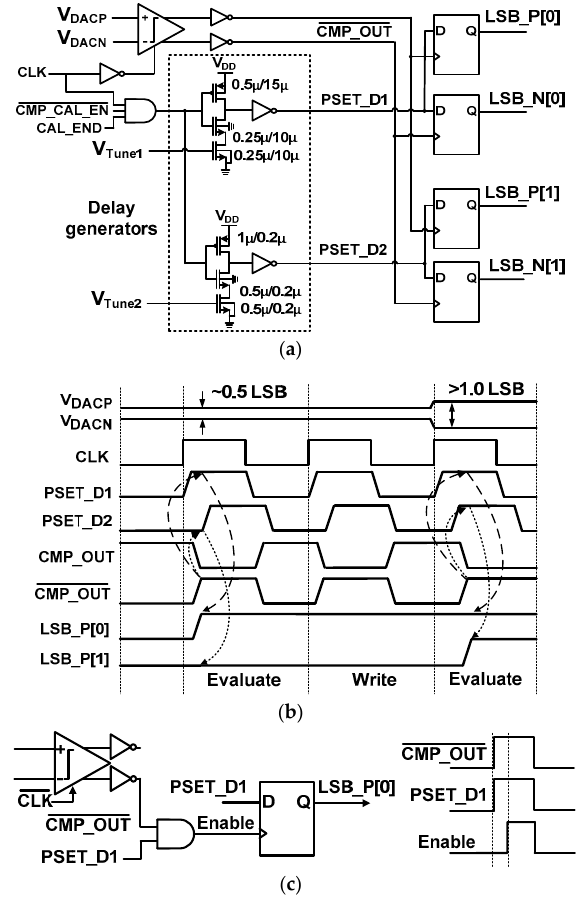
Figure 13. ( a ) Schematic of the delay detector. ( b ) Timing waveform of the delay detector. ( c ) Modified latch control to avoid meta-stability.